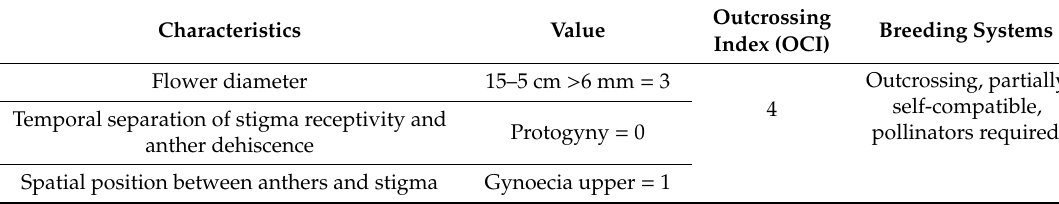
Table 5. Outcrossing index of M. conifera.